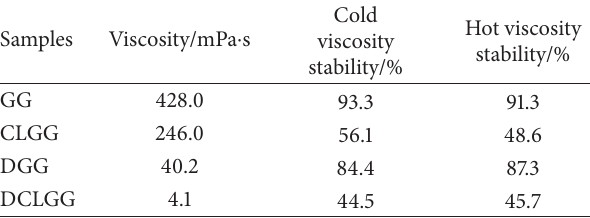
Table 6: Effect of cross-linking and oxidation on cold and hot viscosity stability of